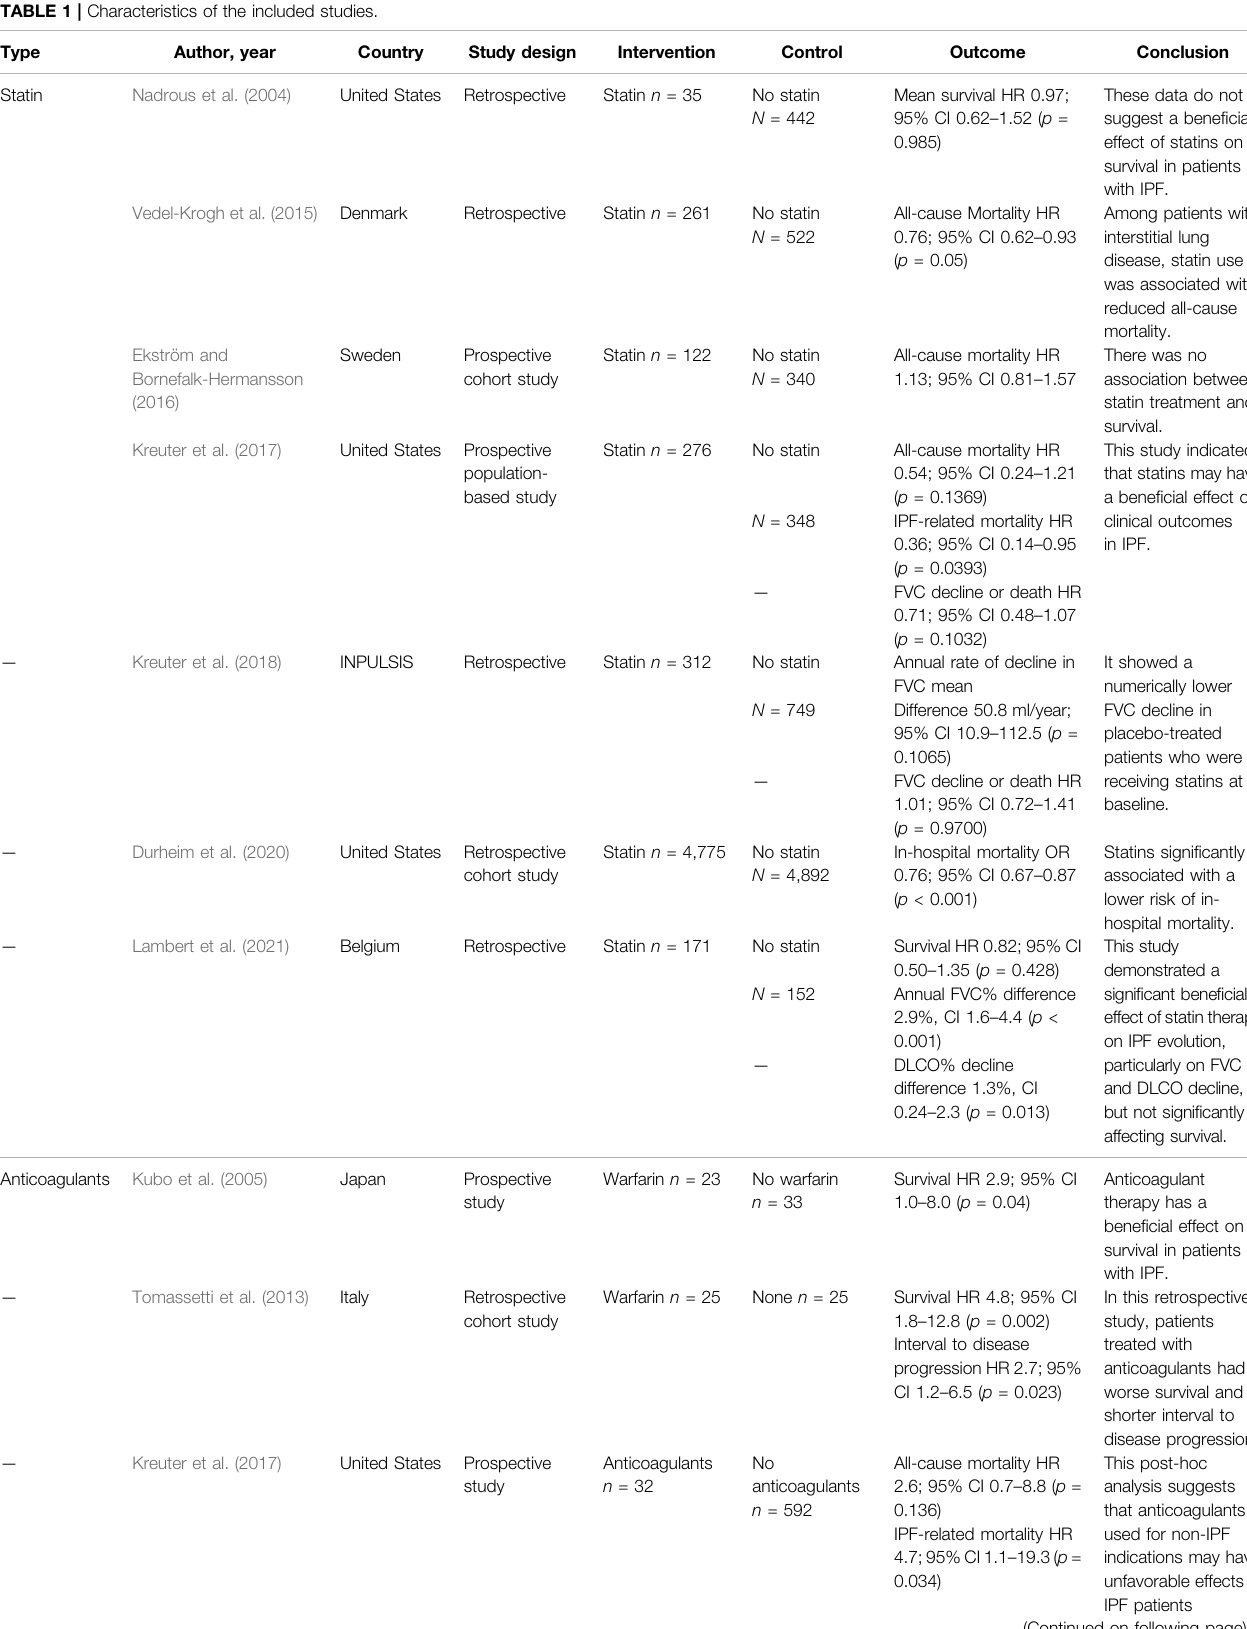
TABLE 1 | Characteristics of the included